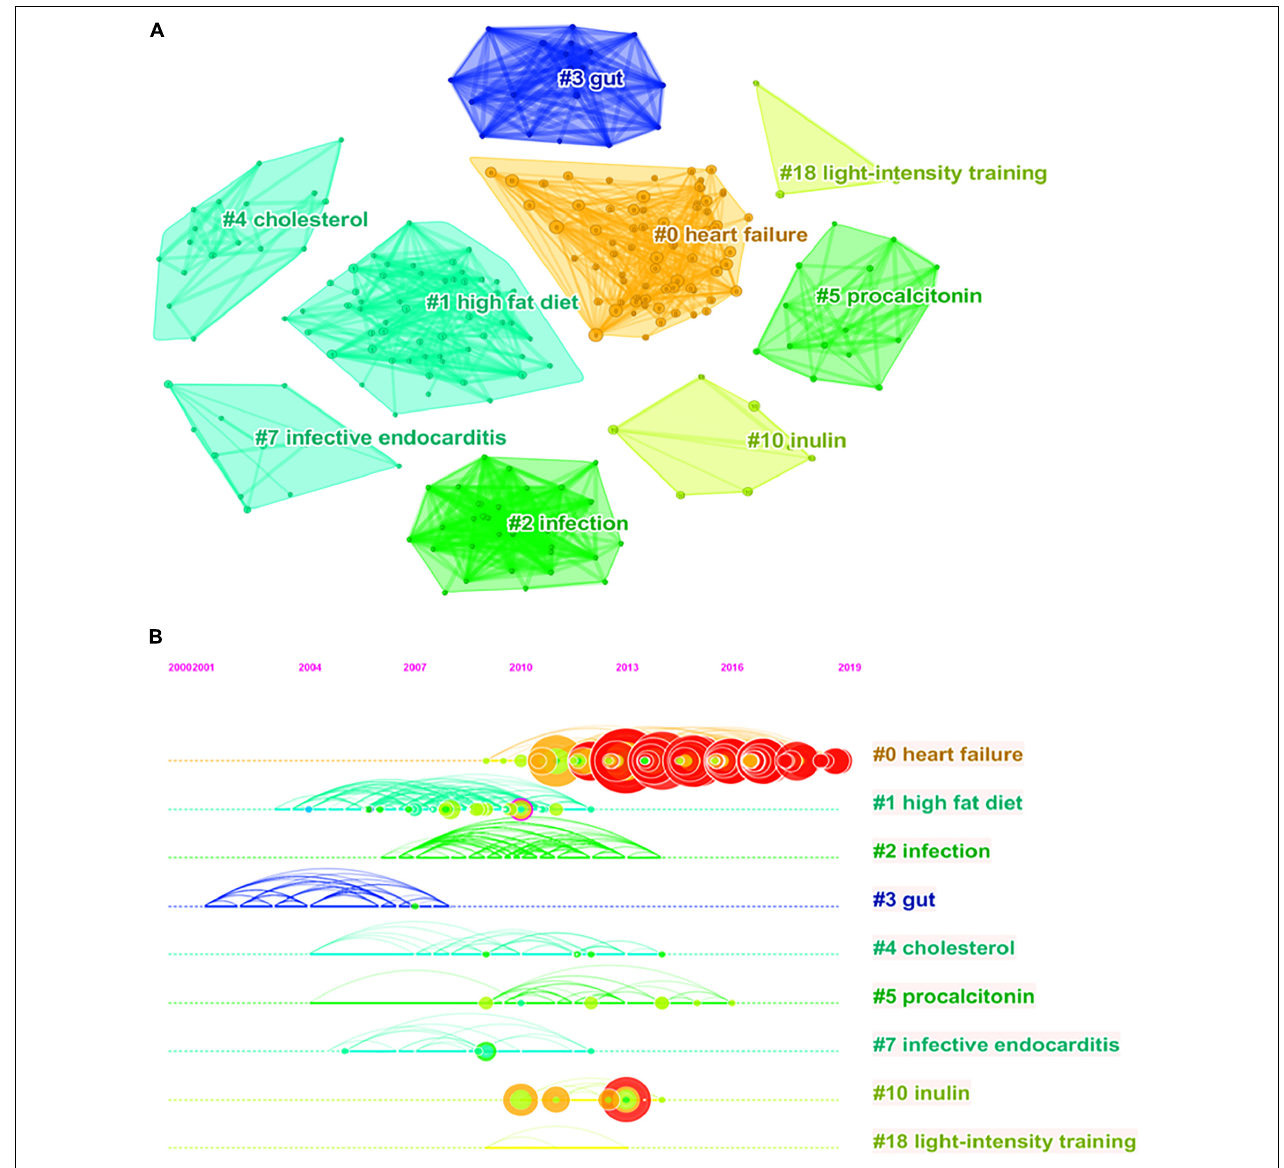
FIGURE 5 | Reference co-citation network knowledge map for research of gut microbiota in the heart failure field from 2006 to 2021. (A) Clustering visualization map of the reference co-citation, labeled with the largest nine clusters. (B) Timeline visualization map of the reference